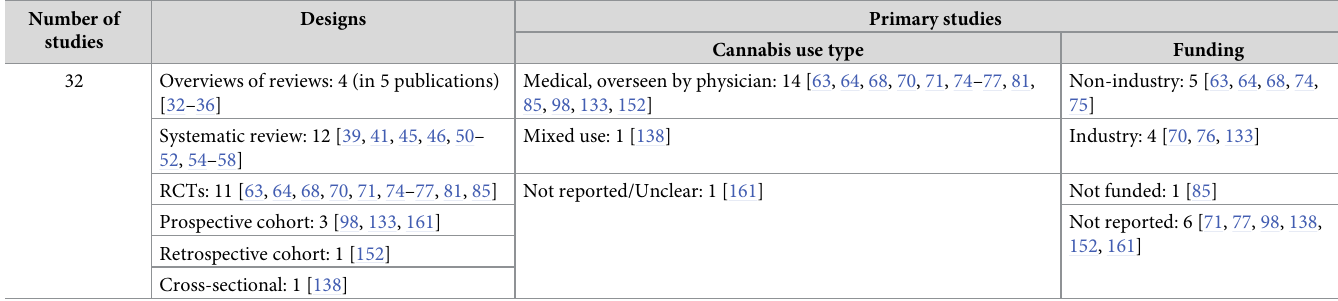
Table 4. Characteristics of studies evaluating the impacts of cannabis use in individuals with end-stage